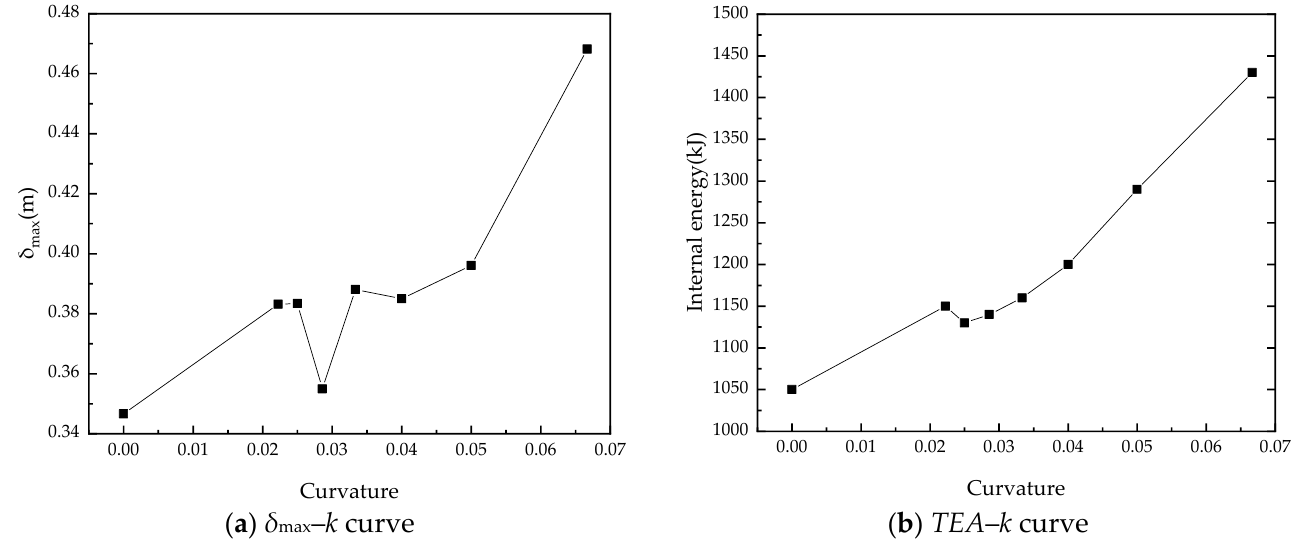
Figure 28. The curve of anti-blast index and different curvature. Furthermore, the deformation contour of the blast wall of OBW-1 and OBW-2 with curvature of 1/20 is shown in Figure 29a,b. It can be seen that the maximum deflection δ max of OBW-1 and OBW-2 is 0.3961 m and 0.3915 m, respectively. The result demonstrates that under the same explosive situation, the two kinds of optimized sandwich blast walls of OBW-1 and OBW-2 can achieve equivalent blast-resistance